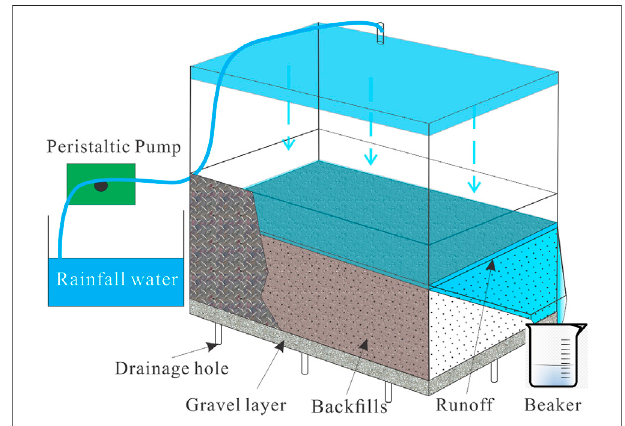
FIGURE1| Schematicoftheexperimentalapparatus(Tongetal.,2010).